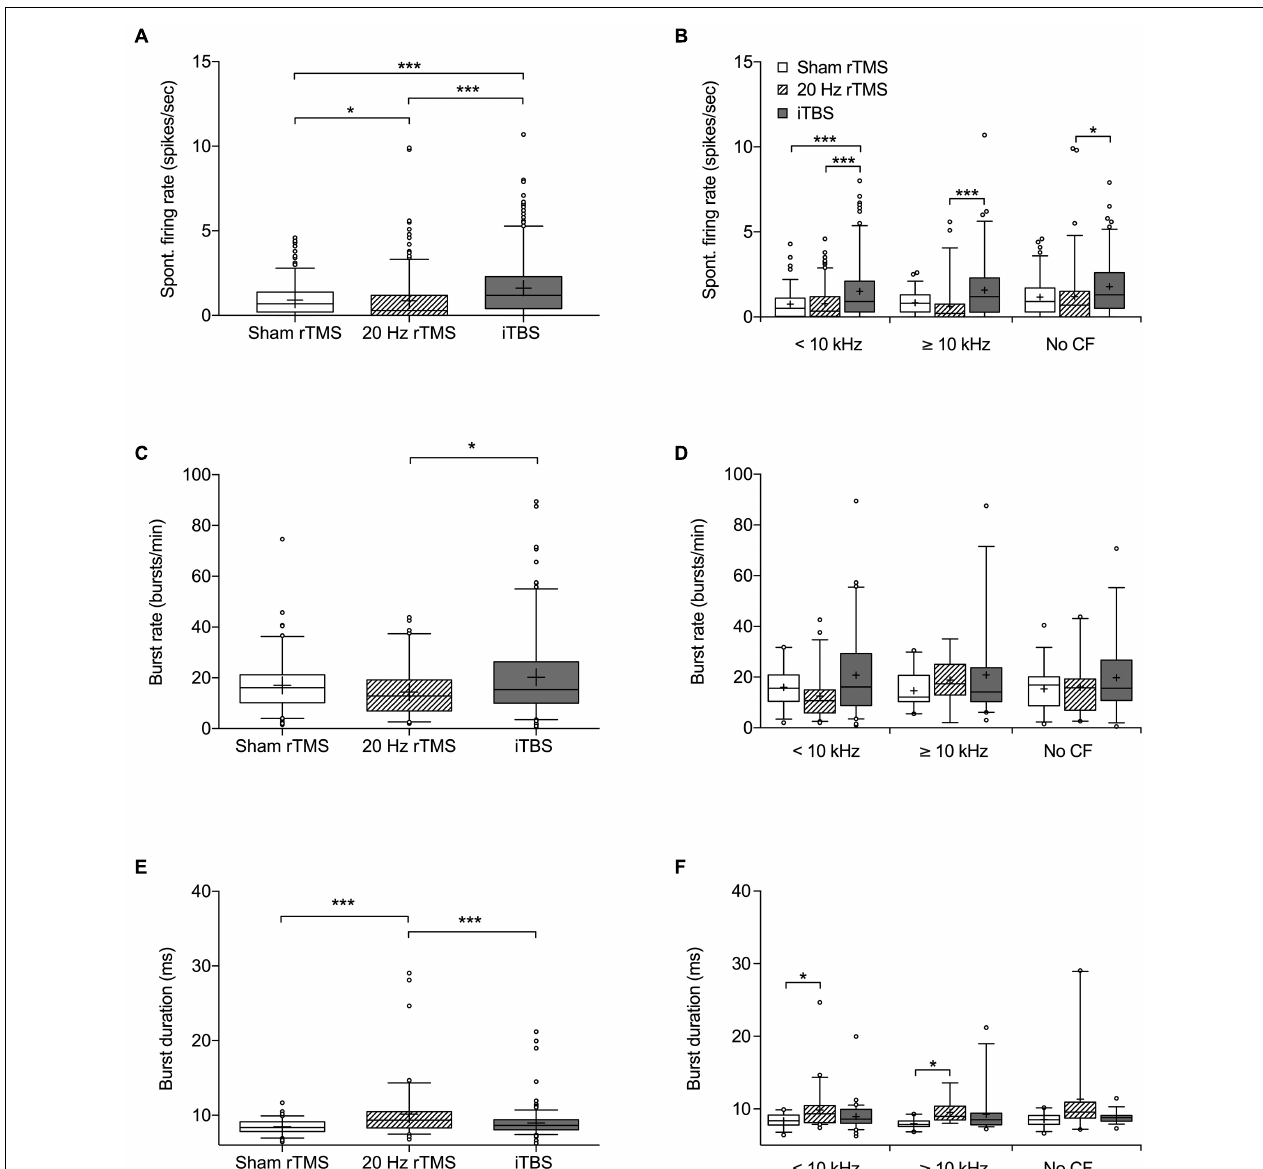
FIGURE 5 | Spontaneous firing rate and burst firing parameters of MGN neurons following rTMS. Box and whisker plot showing (A) spontaneous firing rates based on 272 neurons from sham, 295 neurons from 20 Hz rTMS, and 324 neurons from iTBS group. (B) Spontaneous firing rate of neurons differentiated into CF groups [ < 10 kHz, ≥ 10 kHz, and No CF]. (C) Burst firing rate in bursts per minute based on 107 neurons from sham, 86 neurons from 20 Hz rTMS, and 174 neurons from iTBS. (D) Burst firing rate of neurons differentiated into CF groups [ < 10 kHz, ≥ 10 kHz, and No CF]. (E) Burst duration based on 107 neurons from sham, 86 neurons from 20 Hz rTMS, and 174 neurons from iTBS. (F) Burst duration of neurons differentiated into CF groups [ < 10 kHz, ≥ 10 kHz, and No CF]. All data median with box spanning interquartile range, minimum, maximum and outliers ( > 95%). Mean is indicated by +. Kruskal–Wallis with Dunn’s multiple comparisons, * p < 0.05, *** p <